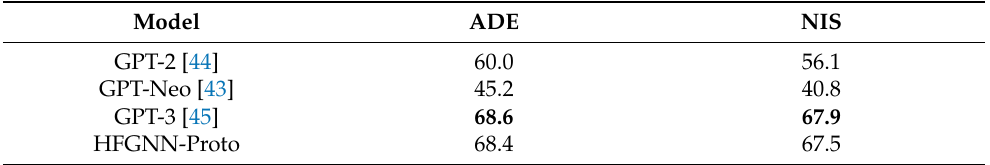
Table 5. Comparison of HFGNN-Proto and PLMs. ADE and NIS are datasets constructed by Alex et al.